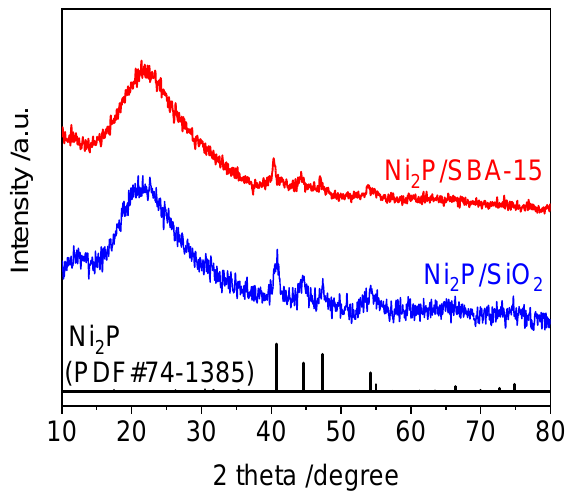
Figure 1. XRD patterns of Ni 2 P/SBA-15 and Ni 2 P/SiO 2 catalysts.